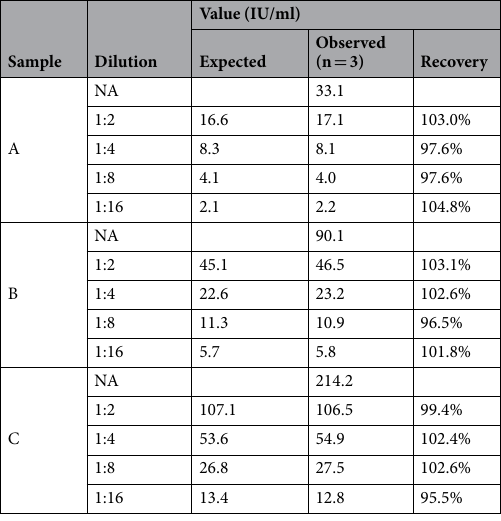
Table 3. Dilution Linearity test of the present TRFIA. NA, not